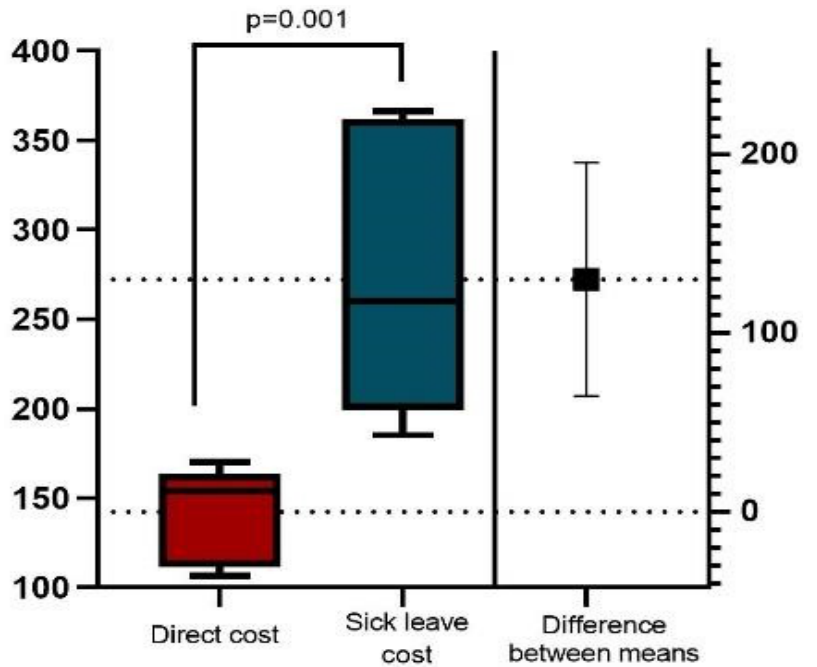
Figure 3. Mean annual patient cost ( € ) (estimation plot and p -value of t -test). The invalidity cost was 23.59% of the total in 2015, 39.19% in 2016, 20.08% in 2017, 34.22% in 2018, 32.83% in 2019, 32.48% in 2020, and 9.15% in 2021 (Figure 4). The number of deaths recorded in the adult population is increasing along with the prevalence of illnesses. The CPL value represented 73.00% in 2015; unfortunately, in 2021, it increased to 89.16%